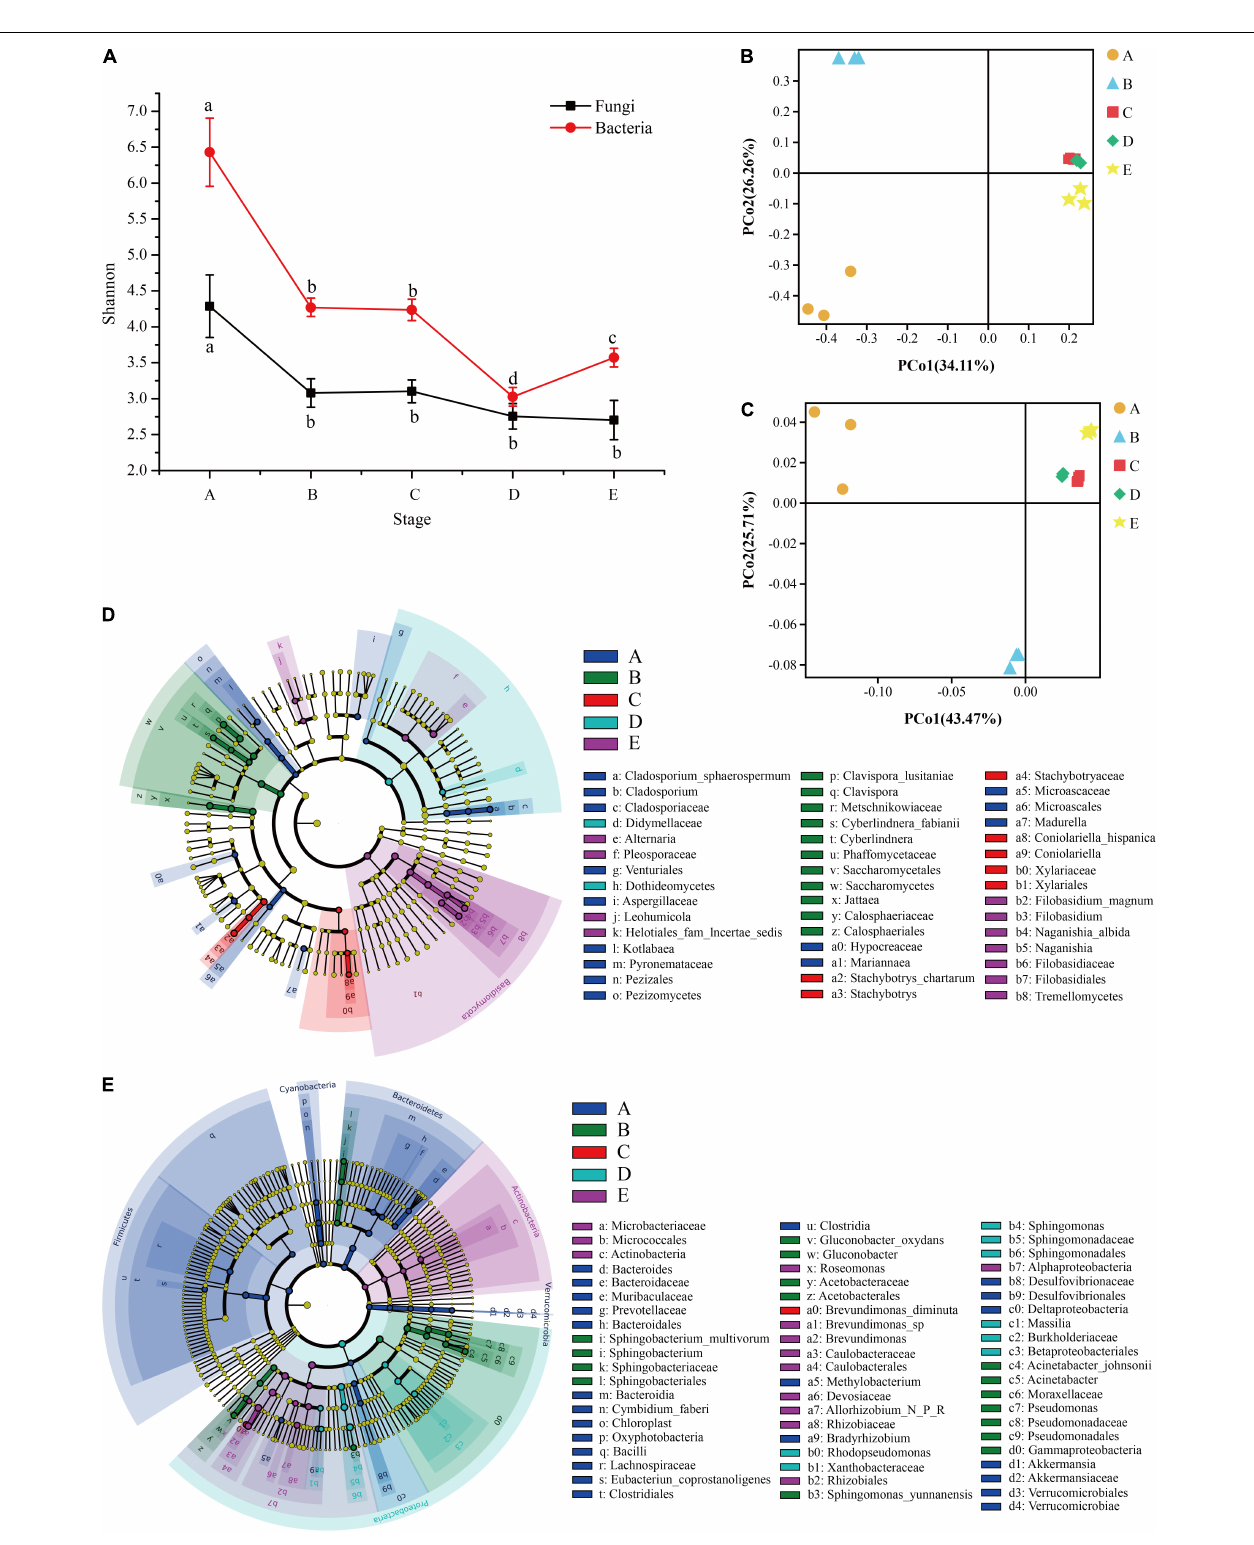
FIGURE 3 | The microbial diversity of the epidermis changes during grape development. The line graph (A) shows the changing trend of fungal and bacterial α -diversity (Shannon index) during grape growth. PCoA plots based on the fungal Bray-Curtis distance (B) and the bacterial weighted UniFrac distance (C) of samples at different stages. LEfSe analysis revealed fungal (D) and bacterial (E) taxa with significant differences at different stages. A, fruit setting; B, early veraison; C, end veraison; D, mid maturity; E, harvest.